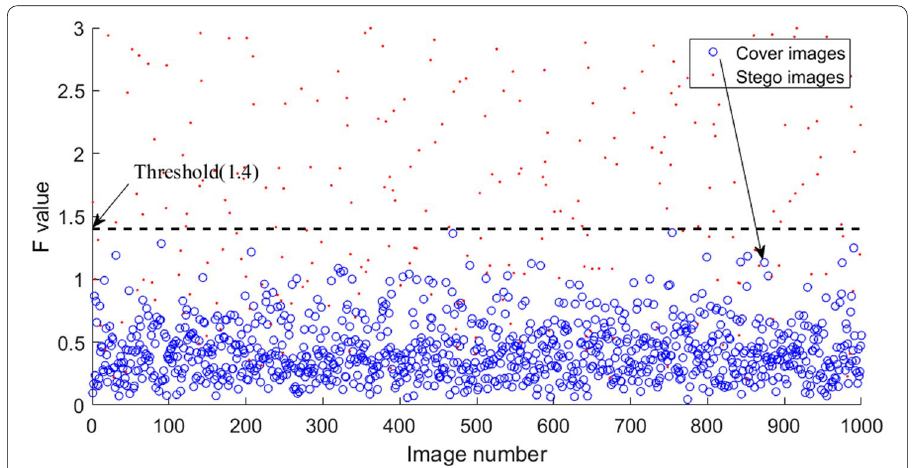
Fig. 12 The threshold of the F value with an embedding ratio of 10% (type 2 of the PVD interval)